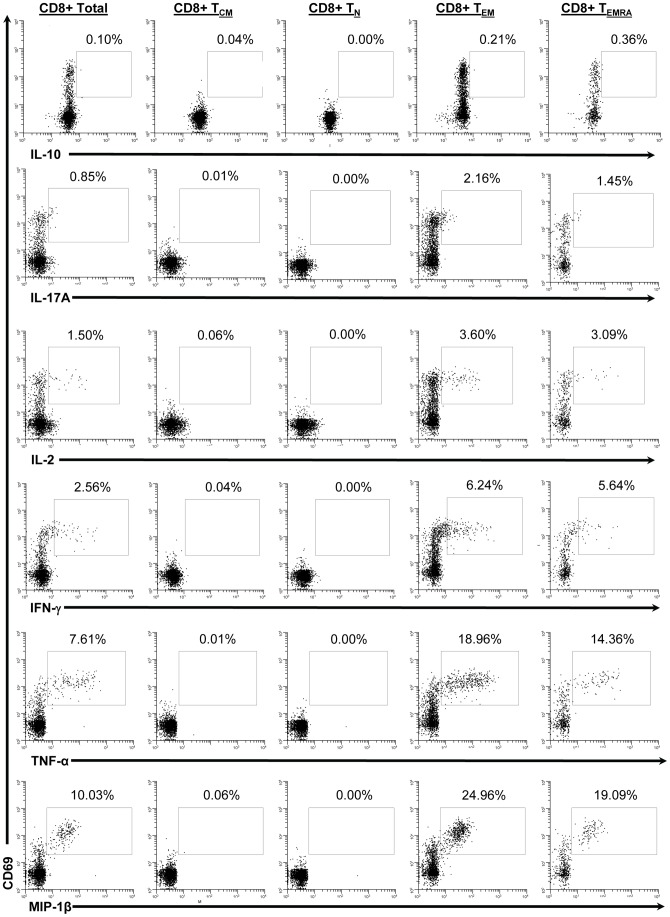
Detection of intracellular cytokines/chemokines produced by CD8+ T cell memory subsets in response to stimulation with S. Typhi-infected HLA-E restricted cells.Histograms from a representative volunteer (53 s at day 7 post infection) showing the production of 6 cytokines/chemokines by memory T cell subsets following stimulation with S. Typhi-infected AEH cells. CD69 (marker of recent activation) is displayed on the y-axis and each of the 6 cytokines/chemokines measured are displayed on the x-axes. Column 1 represents total CD8+ T cells, column 2 represents TCM, column 3 represents TN, column 4 represents TEM, and column 5 represents TEMRA. The percentage of positive cells is shown for the indicated region in each cytogram.